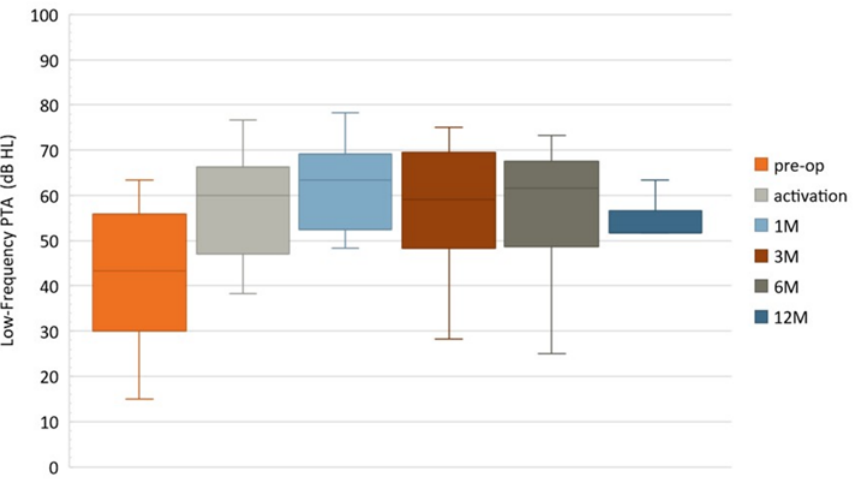
Figure 4. Boxplots of low-frequency (125 – 500 Hz) pure tone audiometry for participants with functional hearing ≤ 80 dB (HL) .